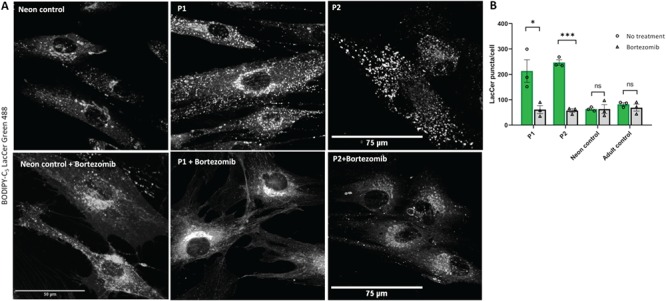
Abnormal BODIPY-LacCer trafficking in patient-derived fibroblasts is corrected by proteasome inhibitor Bortezomib. Patient-derived (P1, P2) or control fibroblasts were grown on 35-mm glass-bottom tissue culture dishes in normal media supplemented with 100 μM of bortezomib (PS-341, Stratech, catalogue number S1013) for 18 h. (A) Fibroblasts were labelled with BODIPY-LacCer and endocytosed BODIPY-LacCer was observed on confocal microscope after 3 h uptake. (B) Quantification of BODIPY-LacCer puncta in the patient-derived and control cells was performed in n ≥ 10 cells per each cell line. Each open circle and triangle represents mean BODIPY-LacCer labelled puncta in untreated and bortezomib treated cells per experiment. The green and grey bars demonstrate mean ± SEM of untreated and bortezomib treated cells from three independent experiments. *, P < 0.05; ***, P < 0.0005; ns, not significant in two-tailed unpaired Student’s t-test. Scale bars: 50, 75 μm.